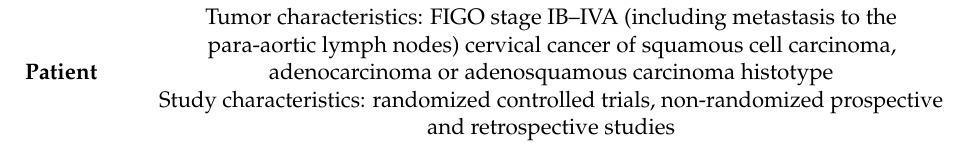
Table 1. Design of the systematic